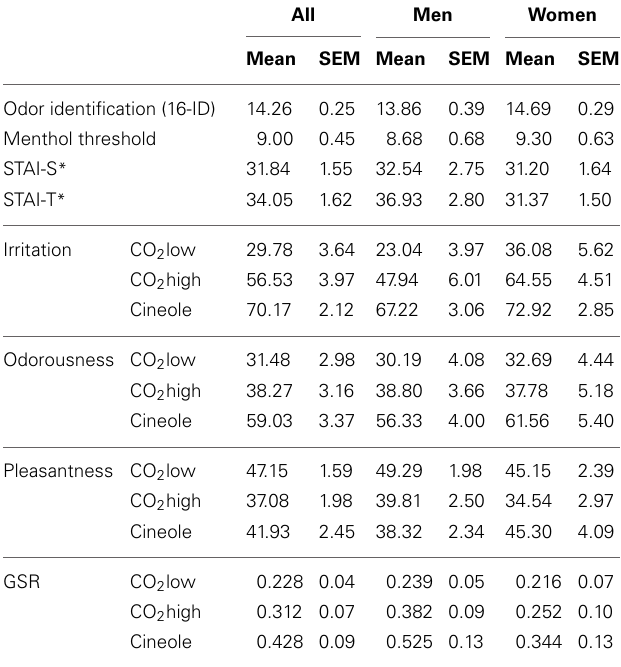
Table 2 | Sensory data, anxiety scores, behavioral ratings, and GSR amplitudes (in µ